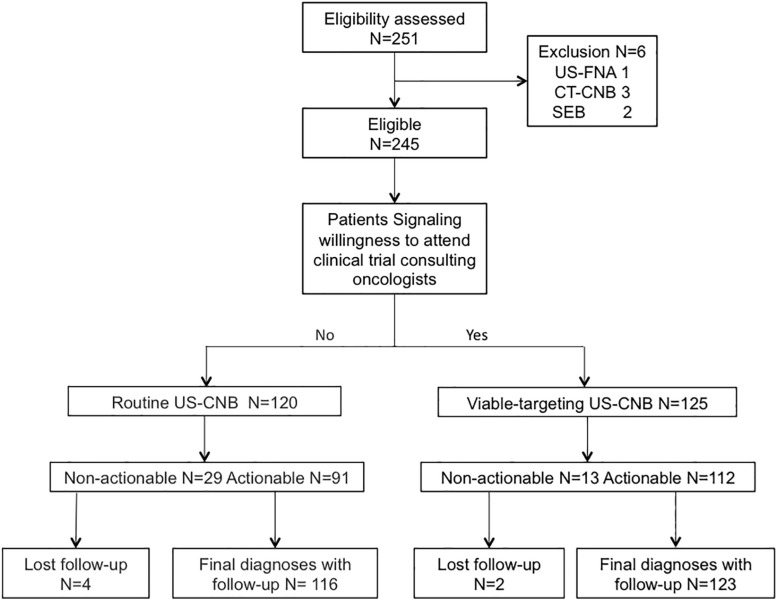
Flowchart of the suspicious lymphoma cases recruited to the viable-targeting and routine ultrasound-guided core needle biopsy groups. US-FNA, ultrasound guided fine needle aspiration; CT-CNB, computed tomography guided core needle biopsy; SEB, surgical excisional biopsy.